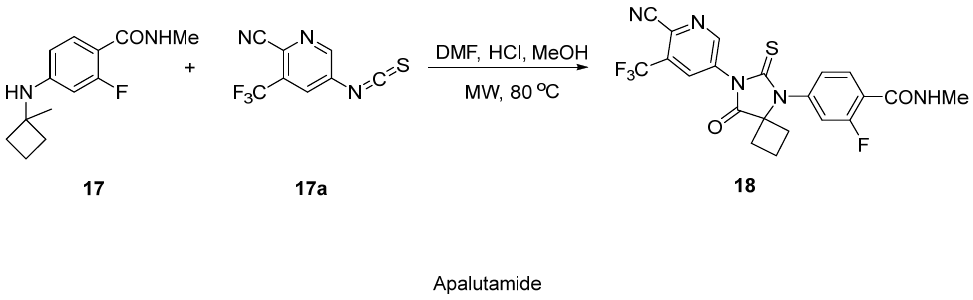
Figure 9. Synthesis and structure of apalutamide.